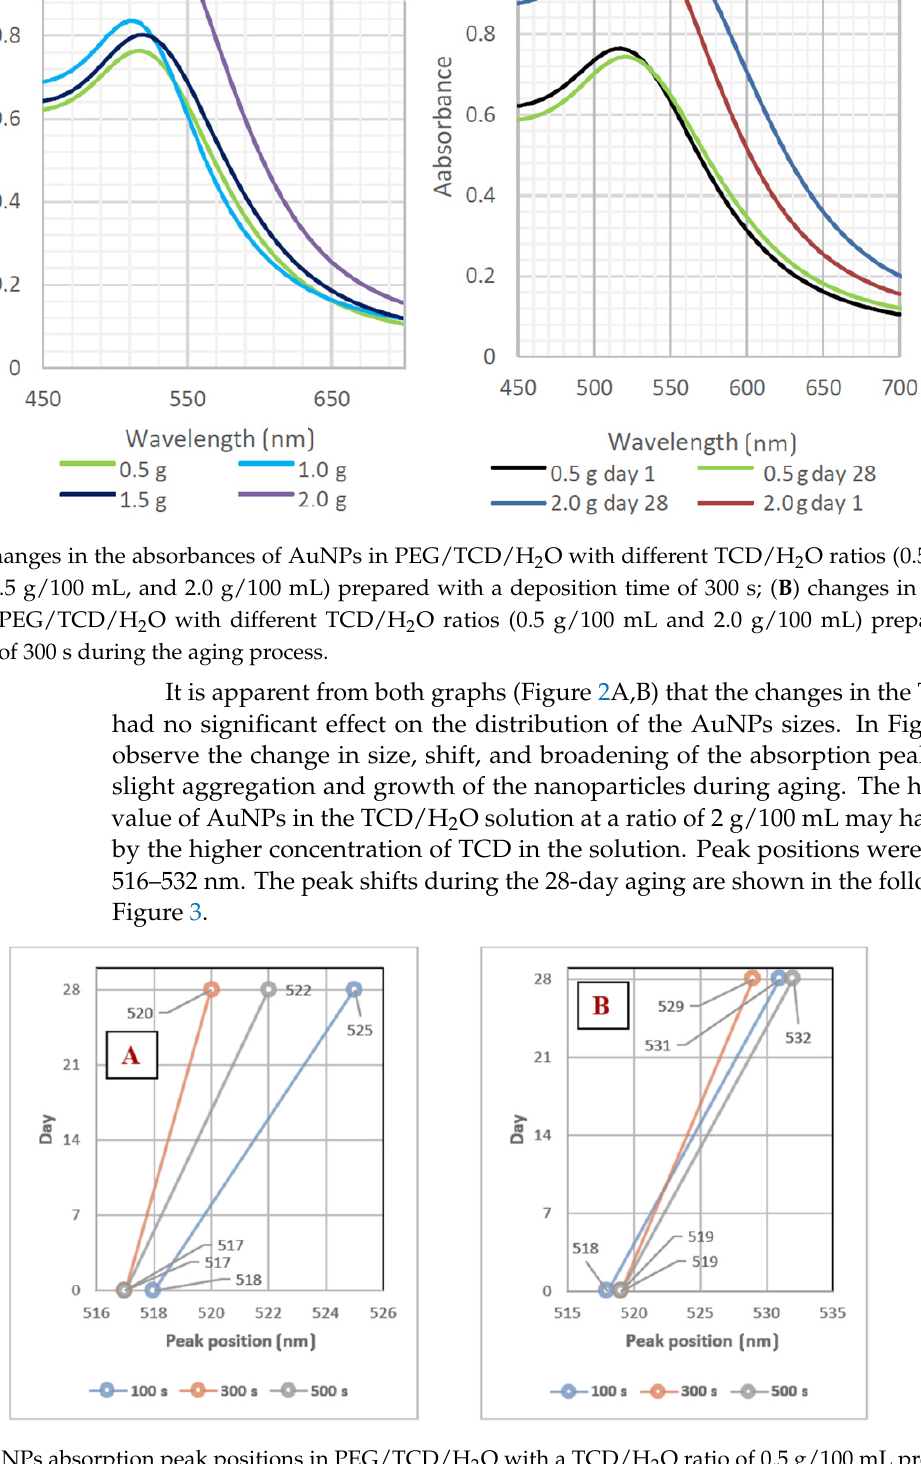
Figure 3. ( A ) AuNPs absorption peak positions in PEG/TCD/H 2 O with a TCD/H 2 O ratio of 0.5 g/100 mL prepared with deposition times of 100, 300, and 500 s; ( B ) AuNPs’ absorption peak positions in PEG/TCD/H 2 O with a TCD/H 2 O ratio of 1.5 g/100 mL prepared with deposition times of 100, 300, and 500